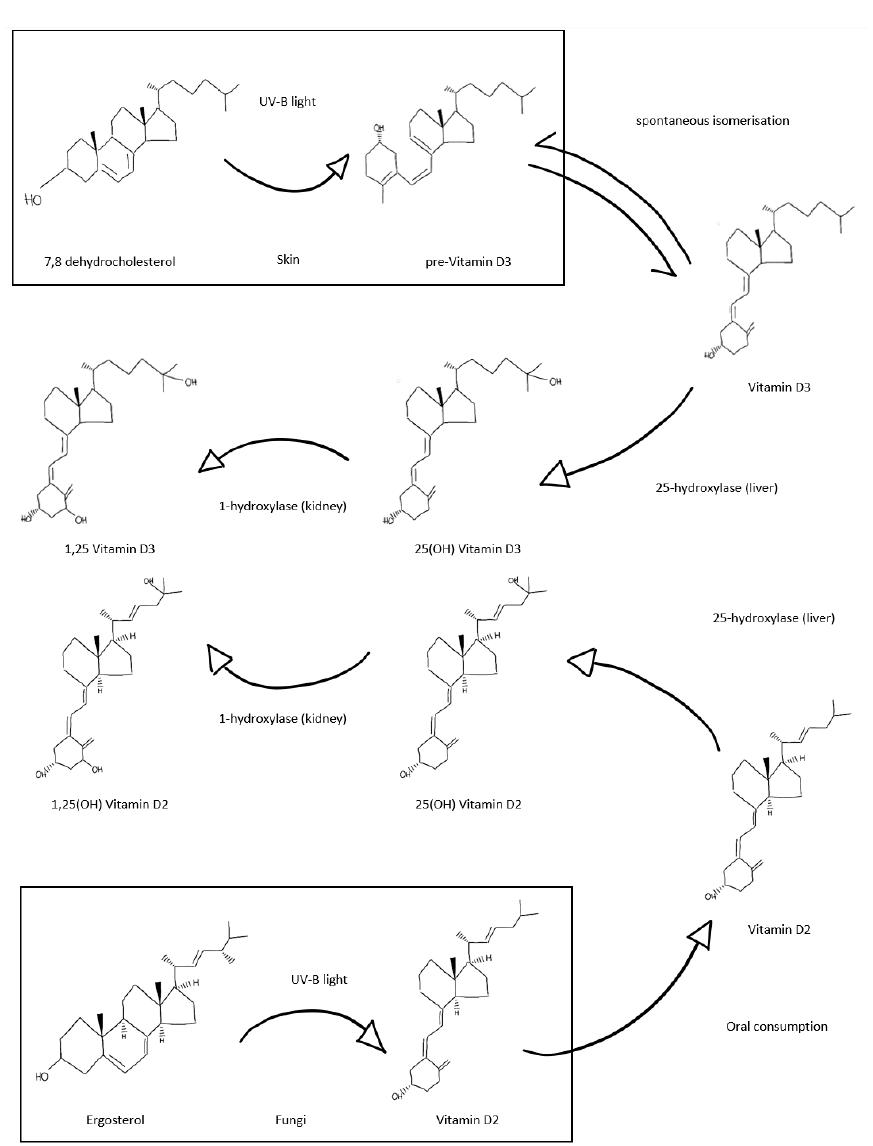
Figure 1. The process of Vitamin D 2 and D 3 production and activation. 7 dehydrocholesterol